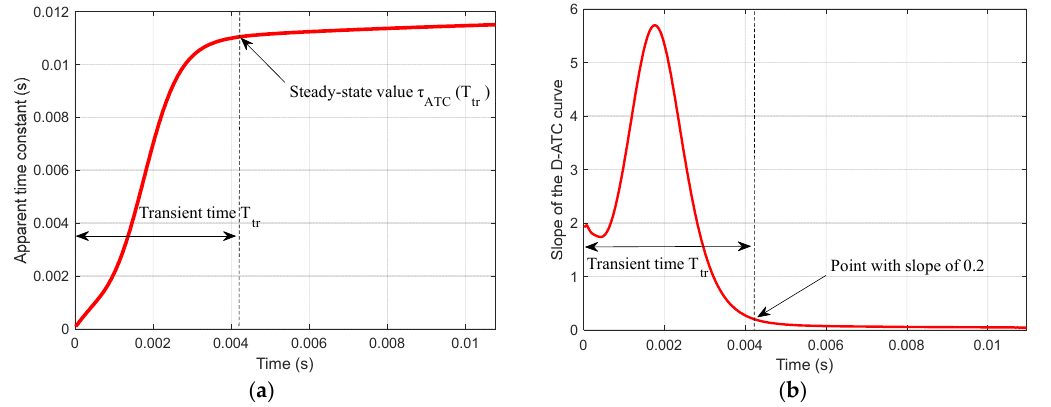
Figure 2. The D-ATC curve and its slope curve of the aluminum plate, the sampling step length is 20 µ s. ( a ) The D-ATC curve presents an obvious rising process, after the transient time T tr , after that the ascent of the D-ATC curve slows down and enters a relatively steady state. ( b ) The time required to stabilize the slope of the D-ATC curve within 0.2 is marked as transient time T tr , and the amplitude of the curve at this time is recorded as the steady-state value.